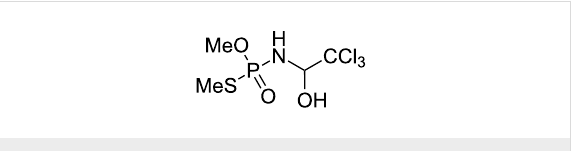
complexes with β -CD [49].